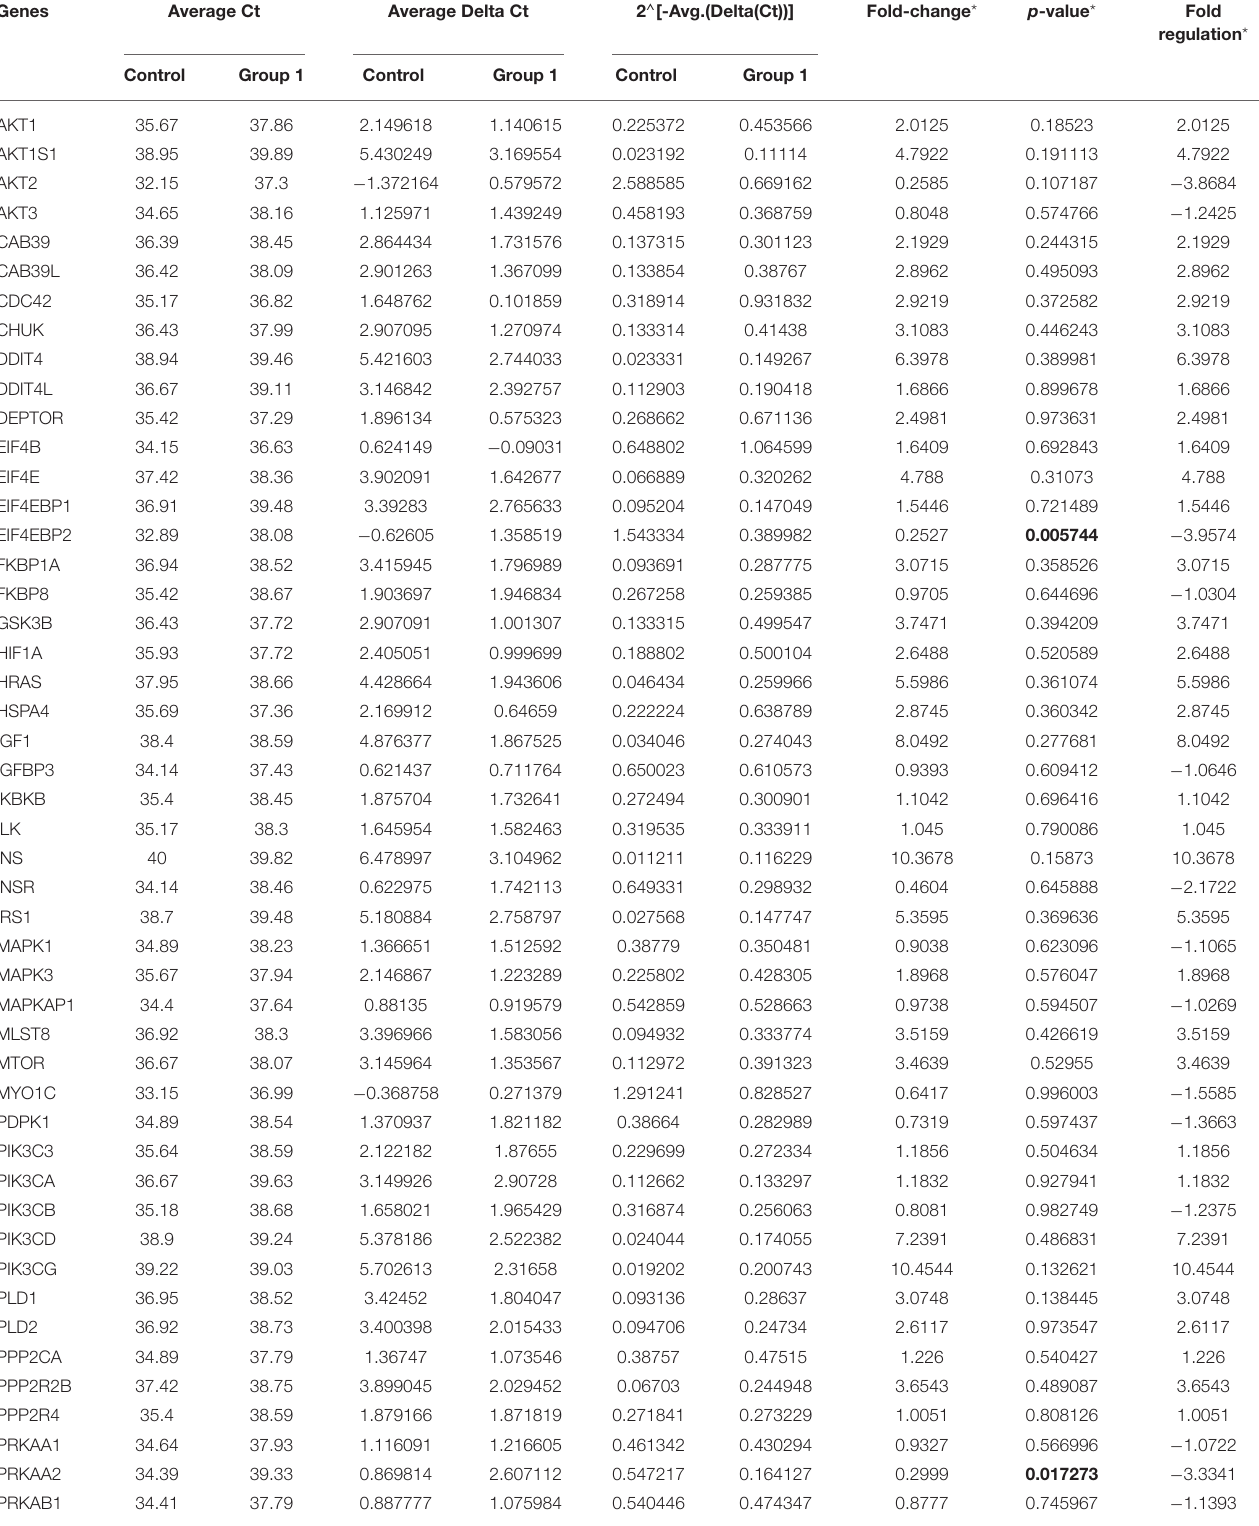
TABLE 3 | Genetic expression of the mTOR pathway in renal biopsies of recipients without rejection used as controls and biopsies from rejected transplants.